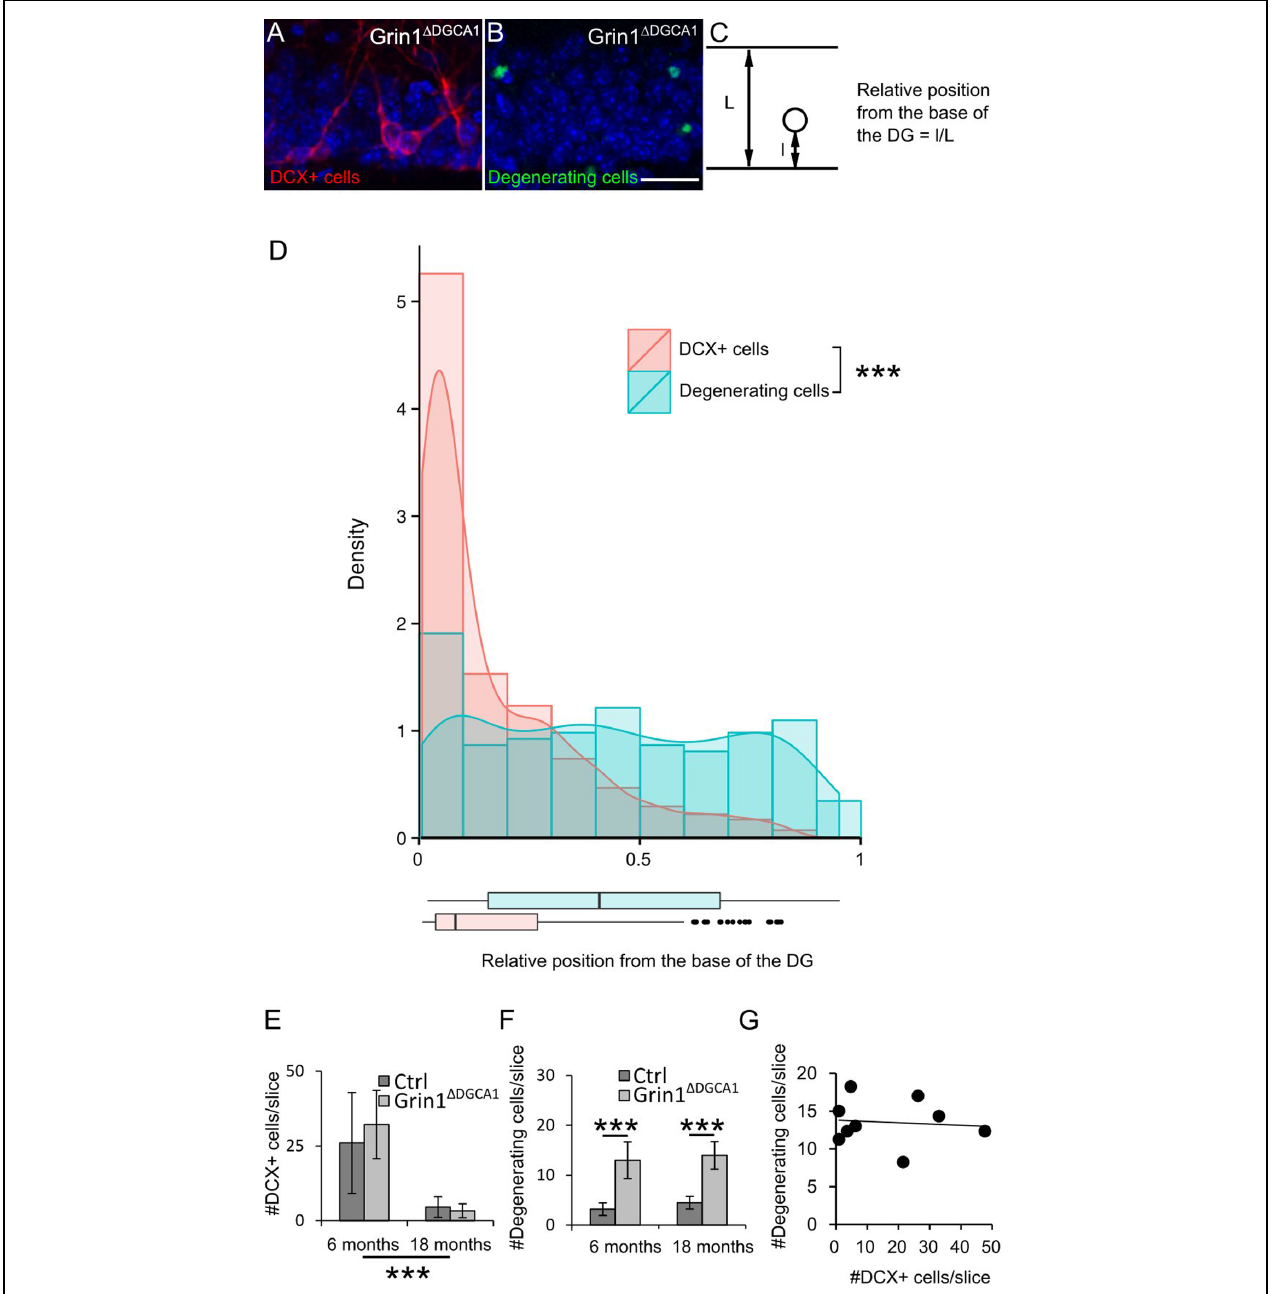
FIGURE 2 | N -methyl- D -aspartate receptor (NMDAR) depletion in Grin1 (cid:2) DGCA 1 mice causes age-dependent degeneration of mature DG granule cells. (A) DAPI stained section (blue) from a 6 months old Grin1 (cid:2) DGCA 1 mouse brain showing DCX-positive (abbreviated DCX + in the figure) neurons (red) located in the inner DG granule cell layer. (B) DAPI stained section (blue) from a 6 months old Grin1 (cid:2) DGCA 1 mouse with degenerating neurons (green) dispersed throughout the layer. (C) Diagram indicating the parameters that were used to calculate the relative position of individual DG granule cells. (D) Histogram, density plot (curved line), and boxplot (bottom) of the relative position of DCX-positive cells (pink) and degenerating cells (blue) showing the differential distribution within the DG granule cell layer (significant difference in both Kolmogorov–Smirnov Tests and Mann–Whitney–Wilcoxon Test, ∗∗∗ p < 0.0005). Whiskers extending from the boxes in the boxplot indicate the maximum and minimum value within the 1.5-fold of the interquartile range from the higher (75th percentile) and the lower quartile (25th percentile). Dots in the boxplot are outliers. This analysis comprised 405 DCX-positive cells and 173 degenerating cells. (E) The number of DCX-positive cells in the DG decreases with age both in control and Grin1 (cid:2) DGCA 1 mice [two-factor ANOVA, F (1,16) = 30.090, p < 0.00005]. There is neither a significant difference between genotypes [ F (1,16) = 0.653], nor a significant interaction between age and genotype [ F (1,16) = 0.423]. (F) The number of degenerating neurons in the DG is higher in Grin1 (cid:2) DGCA 1 mice [two-factor ANOVA, F (1,16) = 85.593, p < 0.00005, followed by post hoc analysis with Holm’s p -value modification, ∗∗∗ p < 0.0005]. There is neither an effect of age [ F (1,16) = 0.247, ns], nor a significant interaction between age and genotype [ F (1,16) = 0.888]. (G) There is no correlation between the number of degenerating and newborn neurons in the DG of Grin1 (cid:2) DGCA 1 mice (Spearman’s rank correlation coefficient test). The same animals were used as in Figure 1 . Scale bar in (B) , 25 μ m.